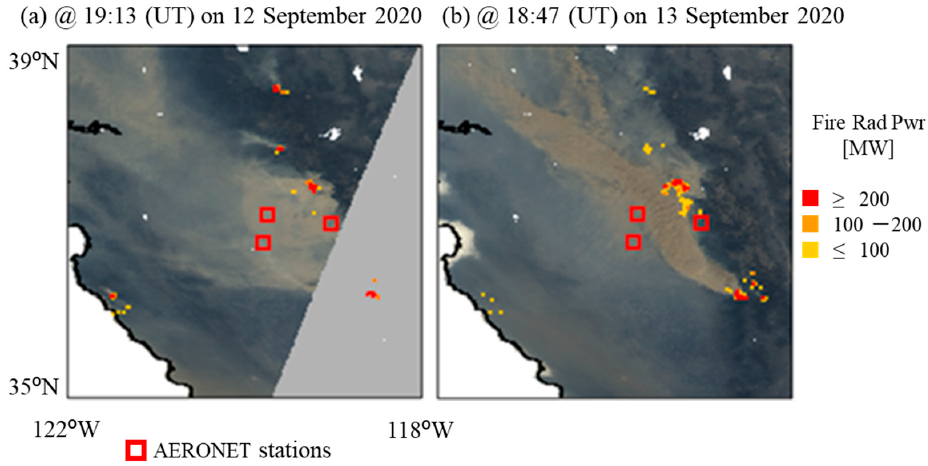
Figure 5. Second-Generation Global Imager (SGLI) color composite satellite images showing hot spots on 12–13 September 2020 (data derived from Terra Moderate Resolution Imaging Spectrometer (TERRA/MODIS/MOD14)). Three levels of wildfire radiative power (Fire Rad Pwr) are illustrated and measured in megawatts (MW). The red squares denote the positions of the three AERONET sites in the focused study area of Area-S (see Figure 4). The gray-colored wedge indicates imaging data that were outside the satellite observation area (Figure 5a). R:G:B = 443:412:380.